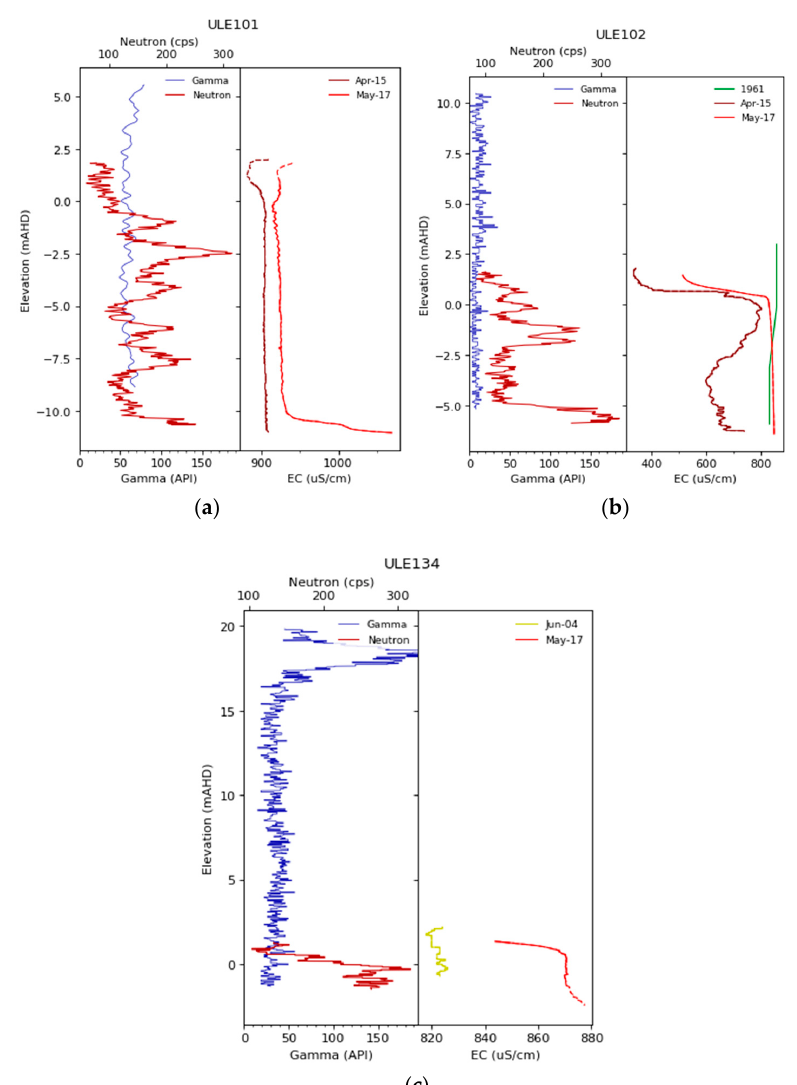
Figure 13. Gamma, neutron, and EC profiles for ( a ) ULE101, ( b ) ULE102, and ( c ) ULE134.